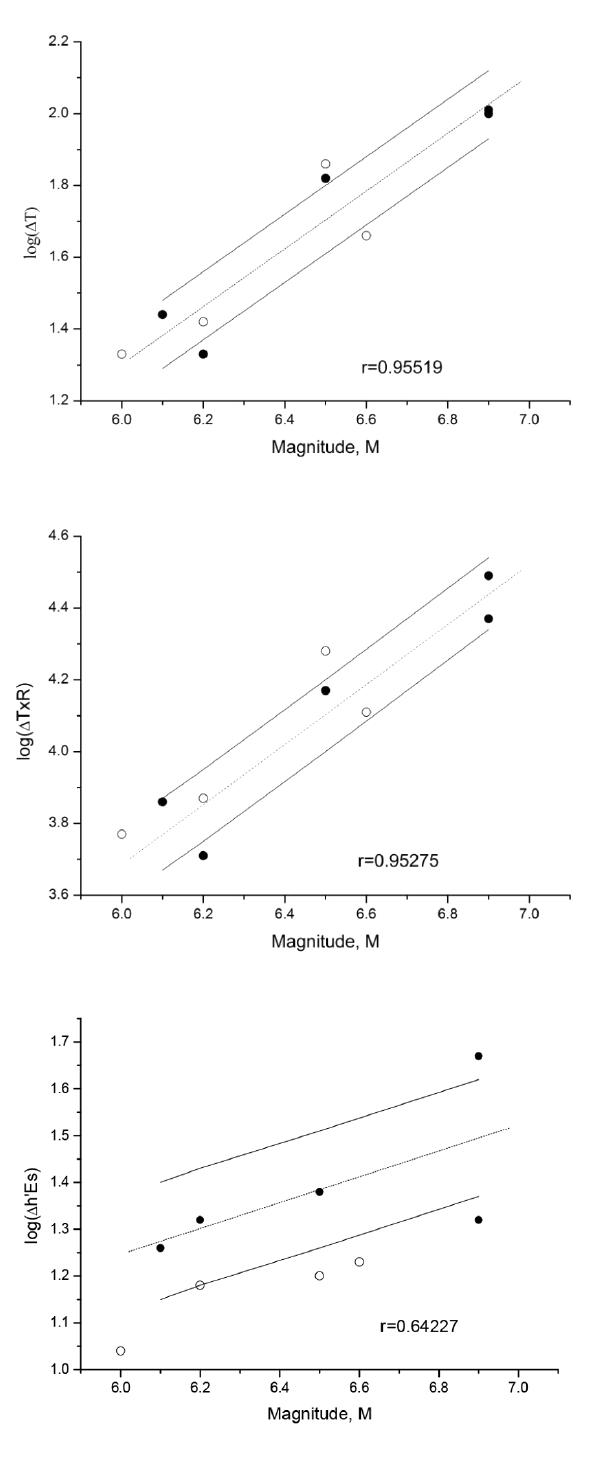
Figure 4. The observed dependencies for log ((cid:49)T ) , log ((cid:49)T × R) and log ((cid:49) h (cid:48) Es) on the EQ magnitude. Correlation coefficients ( r ) of the points from the regression line are given. Each dash line is the best linear fit, while the continuous lines are those correspond- ing to ± 1 standard deviation (SD). Empty squares represent those discarded anomalies characterized by an AE larger than the imposed